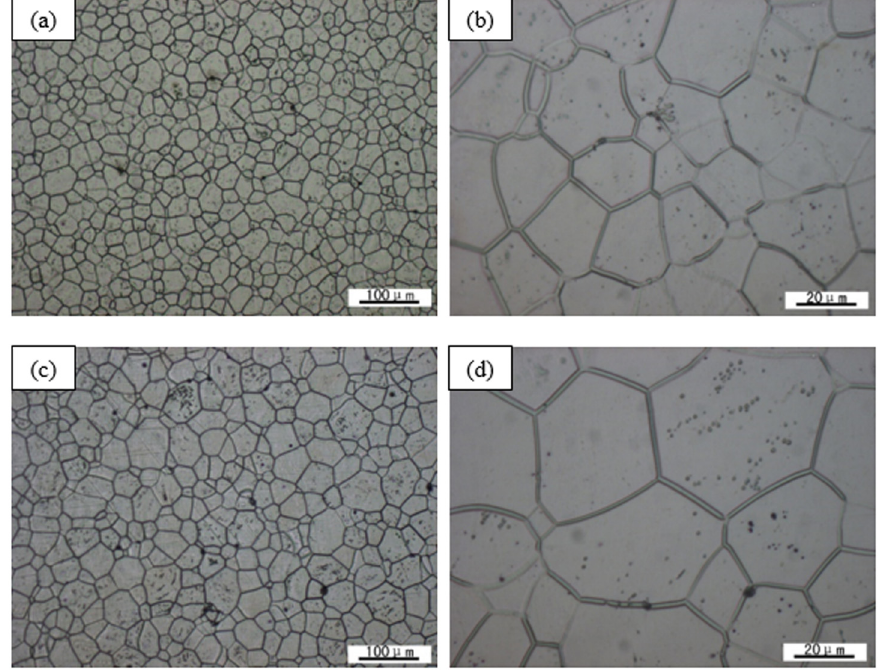
Figure 8. Optical microstructure of as-extruded GWK-a alloy with different extrusion ratio: ( a , b ) 25:1; ( c , d ) 17:1.